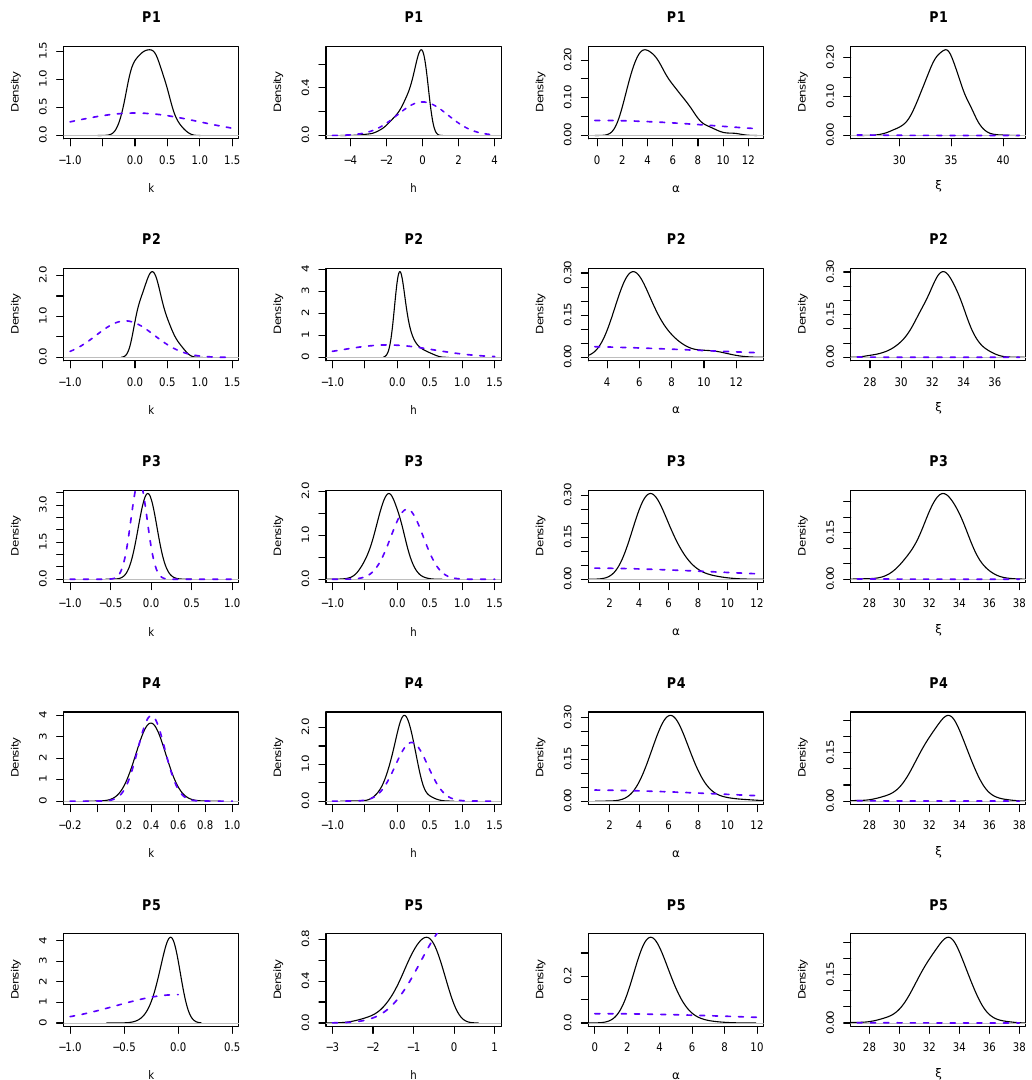
Figure 9. Prior (dashed lines) and posterior (solid lines) densities for each of four parameters ( k , h , α , and ξ ) with the five priors (P1 to P5) considered in the Section 4.2 for the annual maximum wind speed data at Udon Thani,